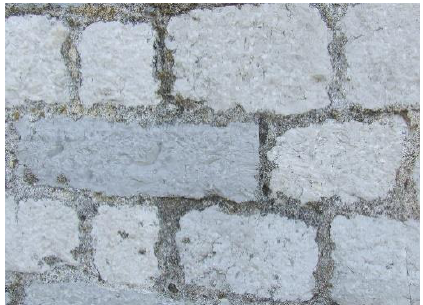
Figure 21. Front façade walls were built using the highly regarded fine stone from Strp and Lipci Figure 21. A house in Lepetani from the second half of the 19th century whose rehabilitation was quarries. carried out in the 1980s of the 20th century.